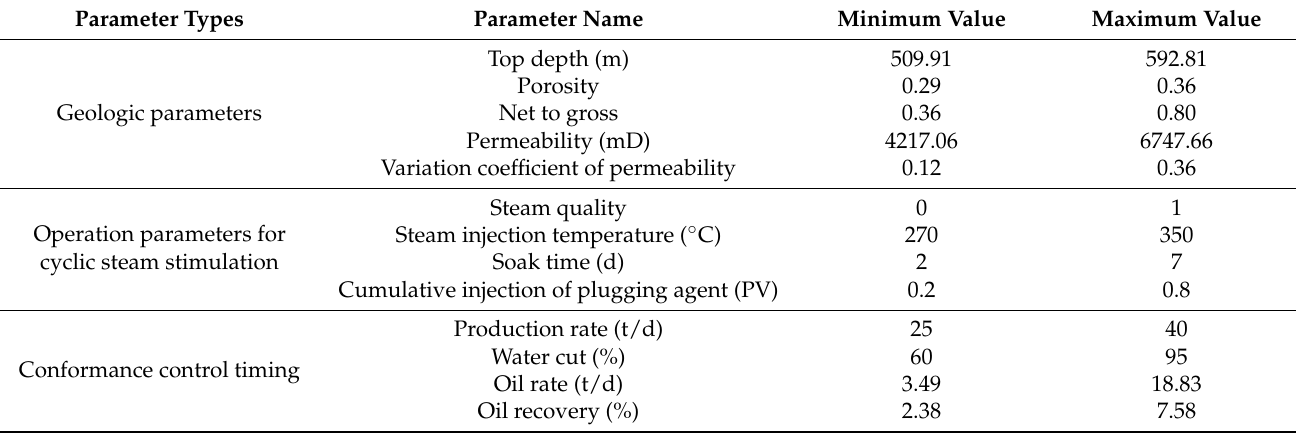
Table 3. Summary of the database used for constructing the estimation